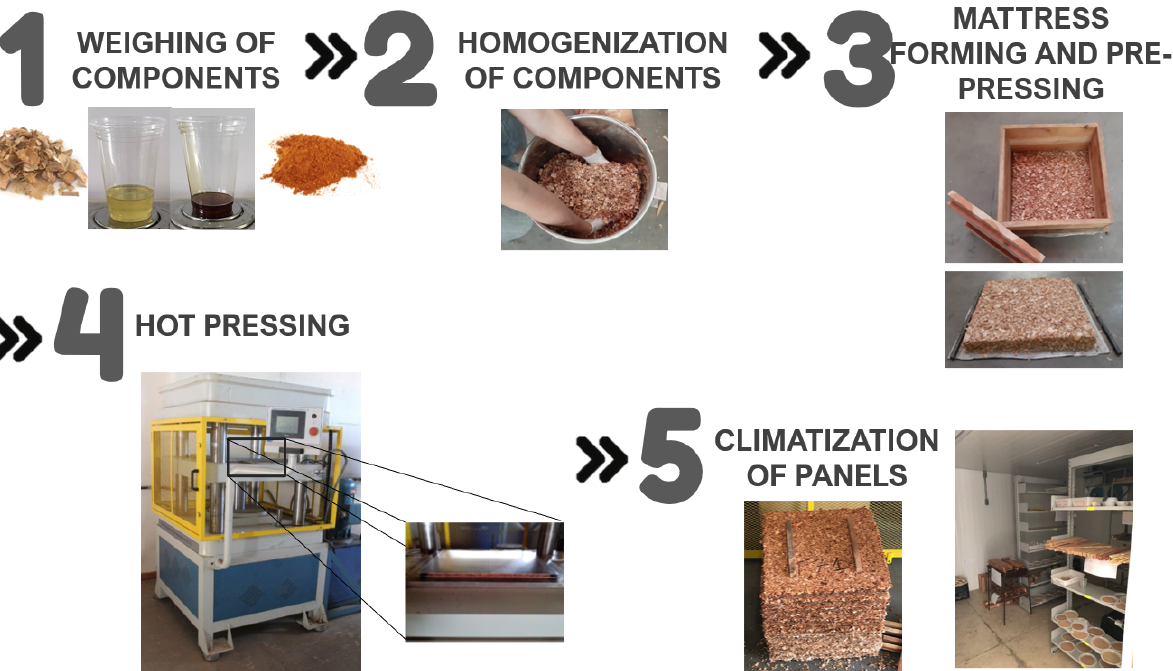
Figure 2. Manufacture panels steps by the hot pressing process.